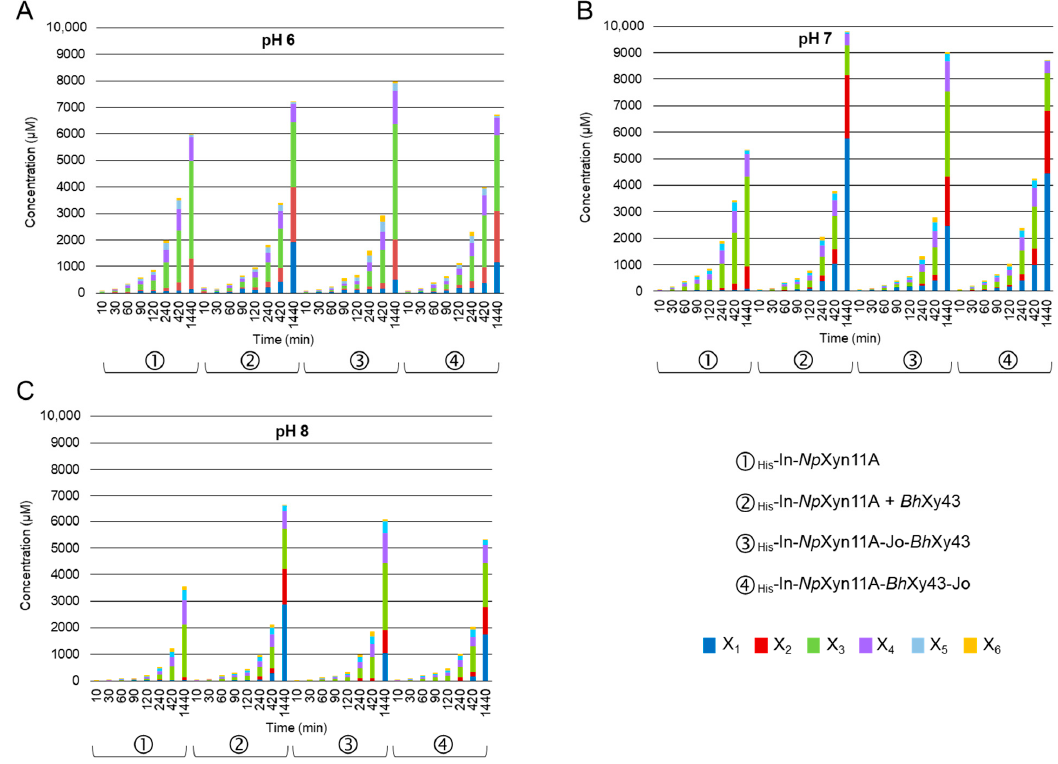
Figure 5. Evolution of the concentration of xylooligosaccharides from X 1 to X 6 at ( A ) pH 6, ( B ) pH 7 and ( C ) pH 8 over time determined by HPAEC-PAD. Hydrolysis conditions: 1 nM of enzymes, 37 °C 1% BWX during 24 h. Representation of the average of triplicate experiments (see Figure S6 for details).